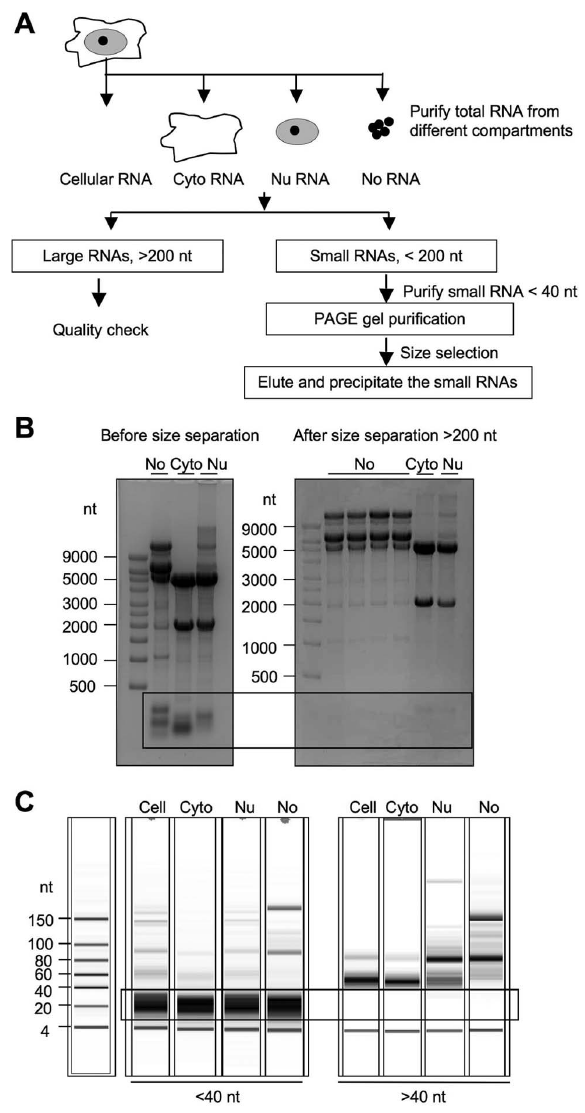
Figure 1. sRNA-seq strategy and preparation of small RNA libraries. A Subcellular fractionation and RNA purification scheme. Cyto, cytoplasmic; Nu, nuclear; No, nucleolar. B RNA-PAGE analysis by 16% denaturing PAGE before ( left ) and after ( right ) purification of the , 200 nt RNA fraction. Subcellular fractions are indicated at the top. C RNA profiles of the , 40 nt ( left ) and . 40 nt fractions ( right ) as analyzed by BioAnalyzer. Subcellular RNA fractions are indicated on top , RNA size markers to the left